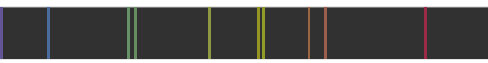
FIG. 3. Task 2. The UW version included another choice, E,